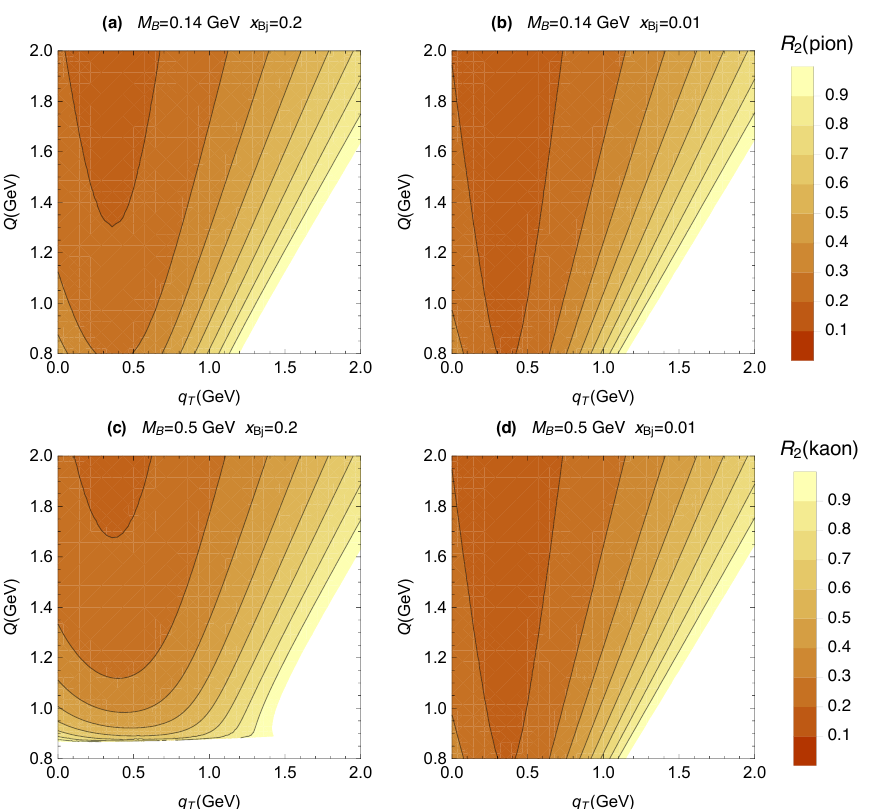
Figure 11 . Transverse momentum hardness, R 2 , from eq. (4.16) for (cid:12)xed z h = 0 : 25, (cid:16) = 0 : 3 and (cid:24) = 0 : 2. Top panels show the ratio for M B = m (cid:25) at (a) x Bj = 0 : 2 and (b) x Bj = 0 : 01. Similar cases for M B = m K are shown in the bottom panels, (c) and